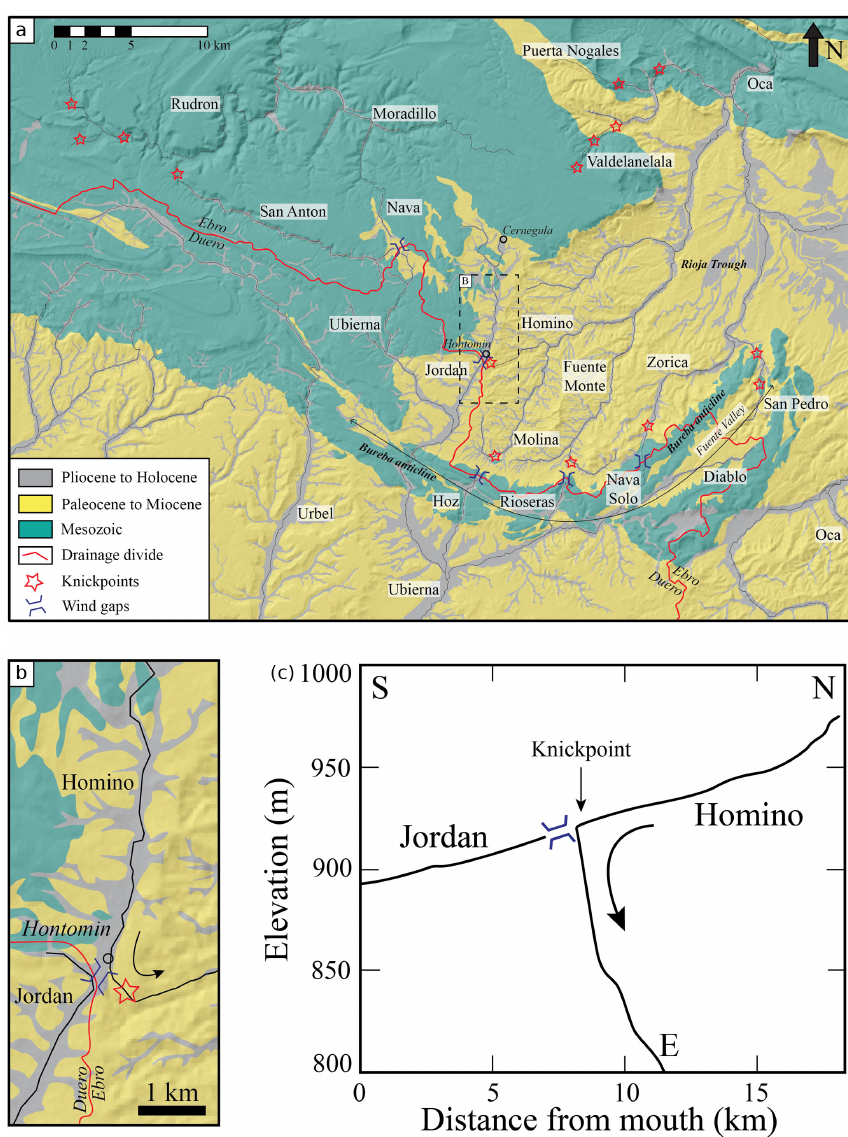
Figure 5. (a) Zoom of the geological map of the Bureba sector. (b) Zoom of the Homino River (Ebro tributary) capturing the upper reach of the Jordan River (Duero tributary). (c) Schematic representation of this capture using river long profiles and map orientation, showing the associated knickpoint and wind